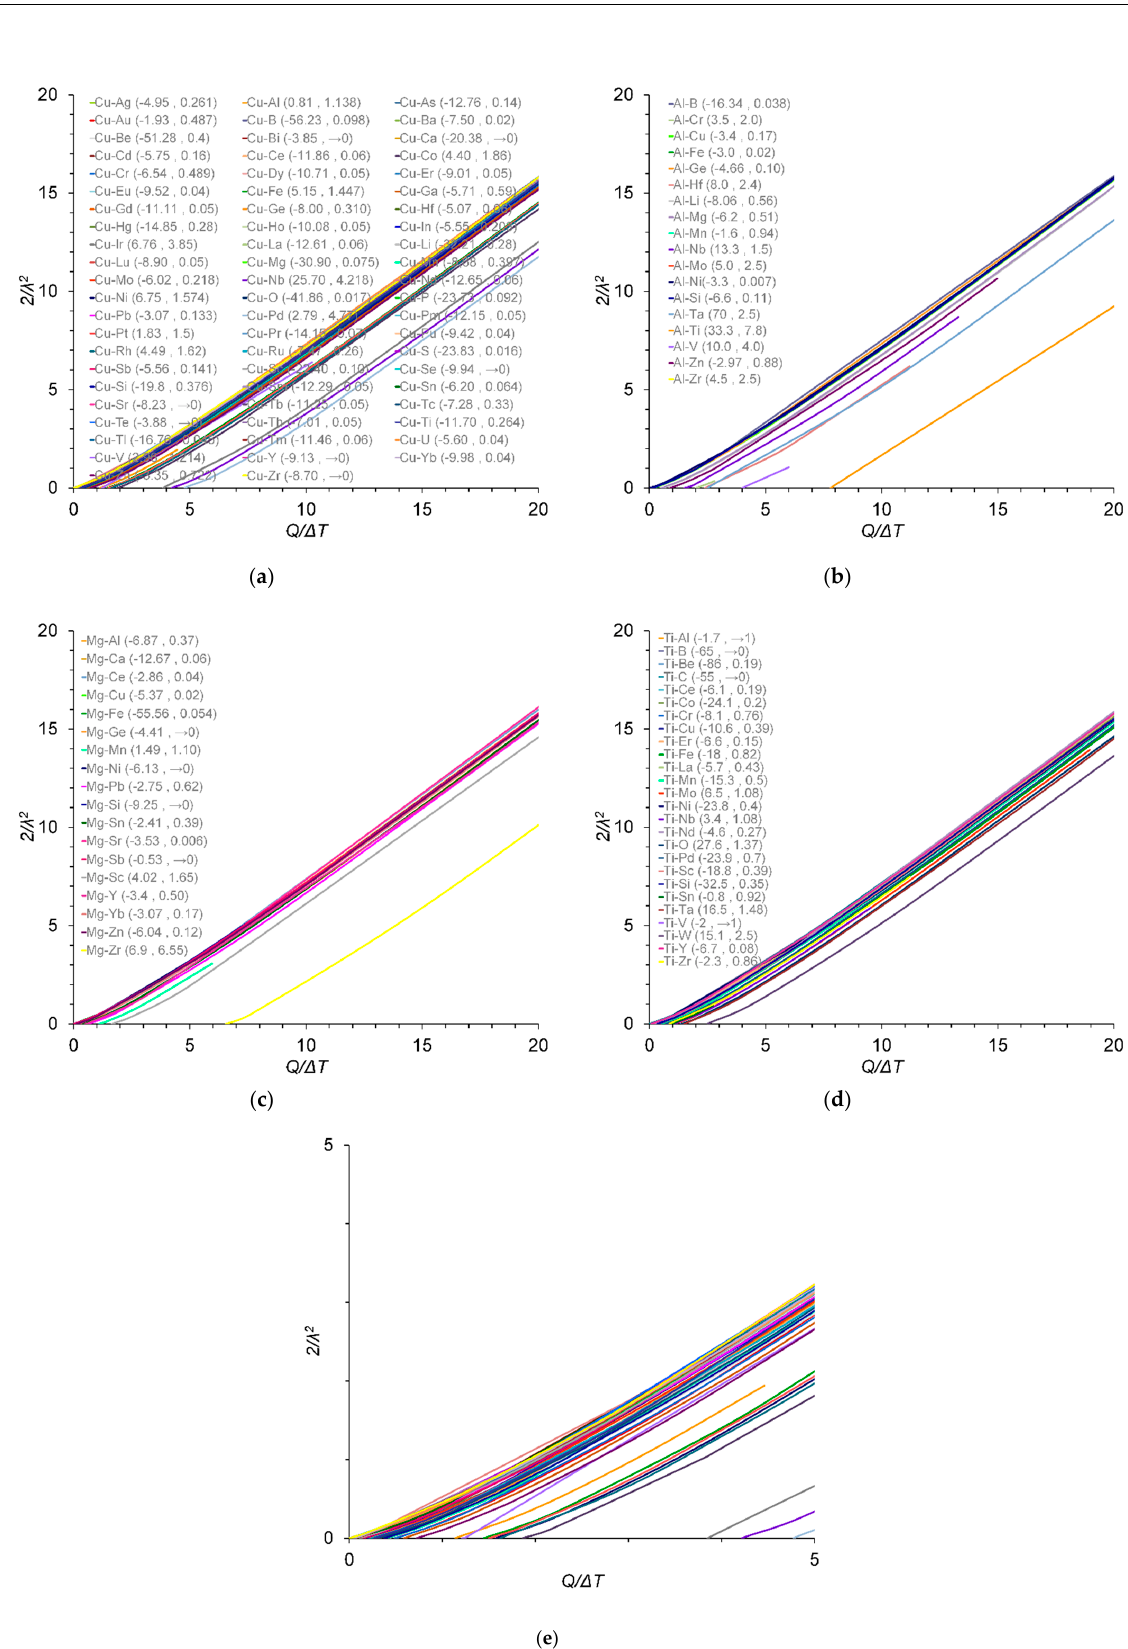
Figure 1. Variation in 2/ λ 2 values with the ratio of Q . to Δ T at Δ T = 0.5 K for ( a ) Cu–X; ( b ) Al–X; ( c ) Mg–X; and ( d ) Ti–X binary alloys; ( e ) zoom-in region from (a). The m and k values are given in parentheses ( m and k ), data from [9,22,23,25–31]. The m and k values for the Al–B binary alloy were calculated in this work.